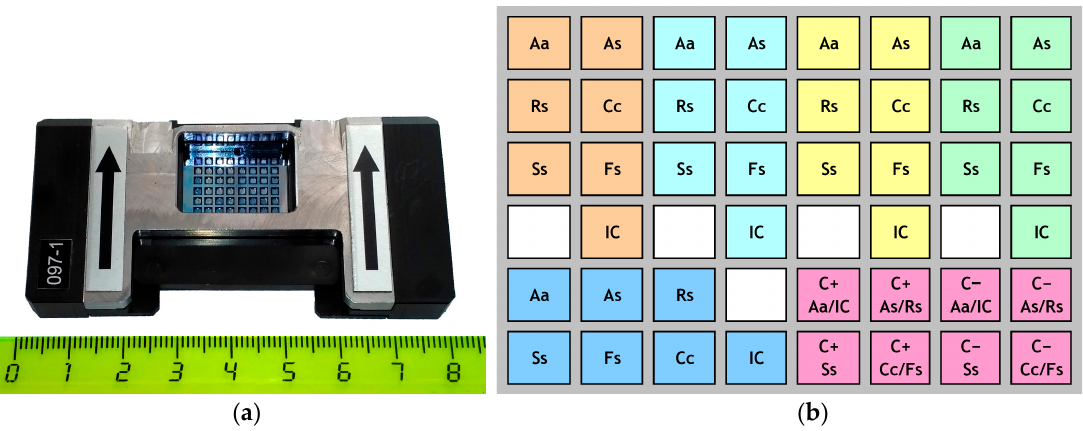
Figure 1. Microarray designed for diagnostics of fungal pathogens of potato: ( a ) 48-well microarray in a holder (the numbers on the ruler represent centimeters); ( b ) microarray topology for simultaneous analysis of five samples (shown by different colors). Indications: Aa, Alternaria alternata ; As, Alternaria solani ; Rs, Rhizoctonia solani ; Cc, Colletotrichum coccodes ; Ss, Spongospora subterranea ; Fs, Fusarium spp.; IC, internal control sample; C+, positive control; C − , negative control.